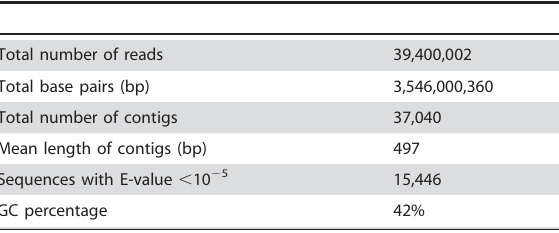
Table 1. Summary for the Chilo suppressalis midgut transcriptome.